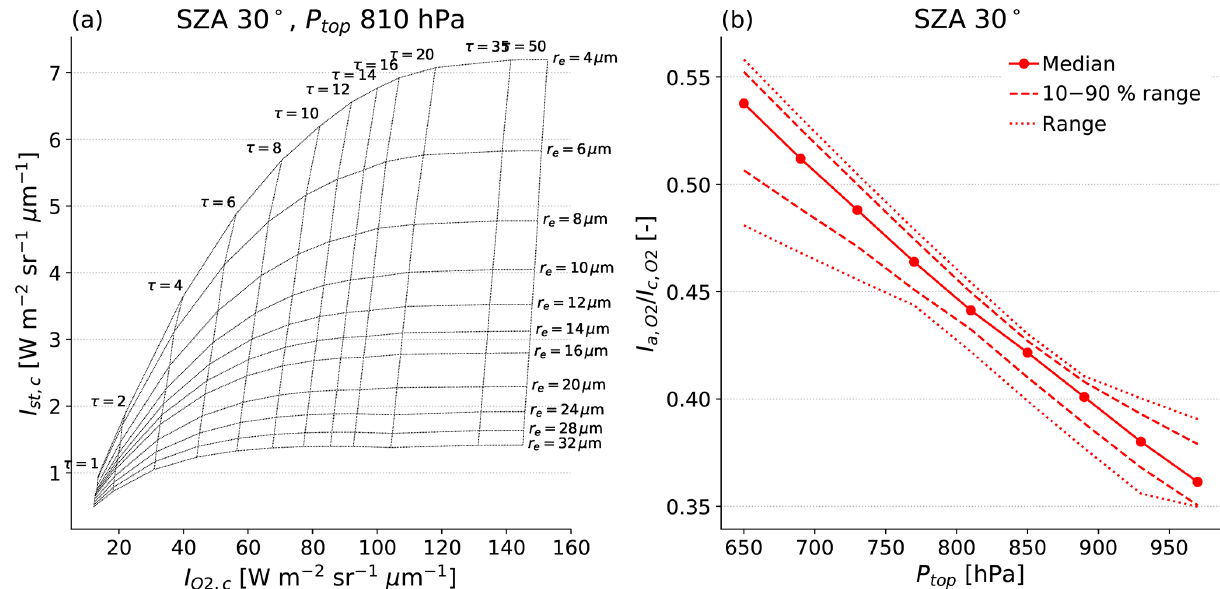
Figure 4. Example lookup table (LUT) properties. (a) Radiance in the strong CO 2 continuum as a function of A-band continuum radiance at SZA = 30 ◦ for clouds with P top = 810hPa and τ and r e as labelled. (b) A-band absorption ratio within the SZA = 30 ◦ table as a function of P top . The solid line is the median value within each LUT at a fixed P top ; the dashed lines span the 10%–90% range, and the dotted lines span the minimum to maximum values.